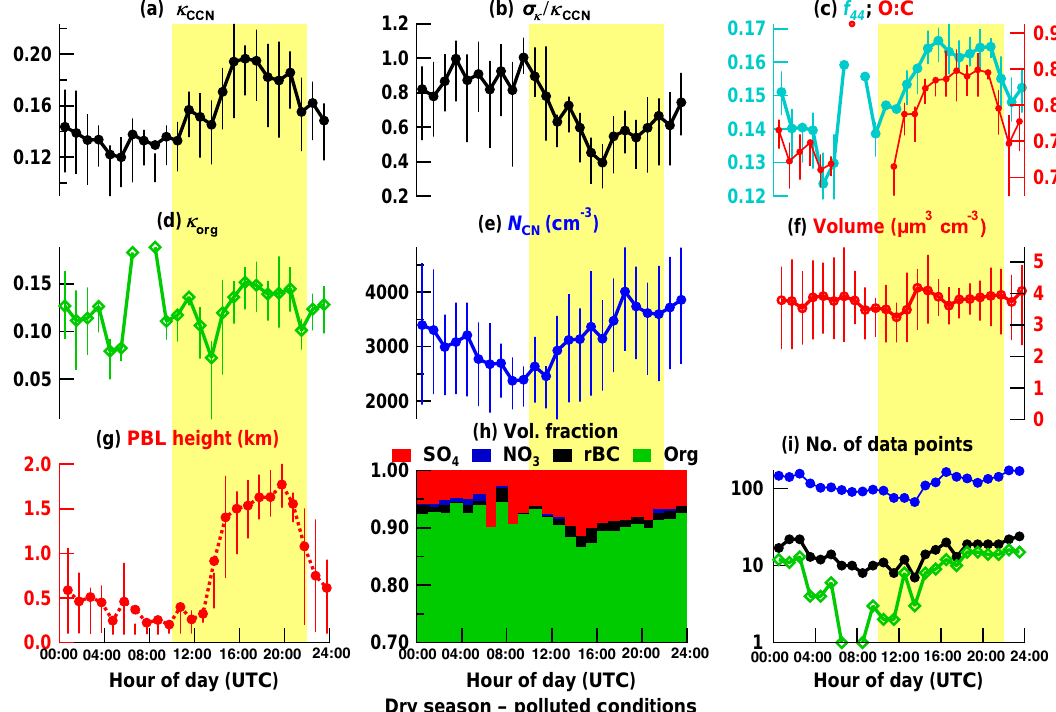
Figure 6. Diel variations of aerosol properties and meteorological parameters for urban pollution air masses during the dry season (analogous to Fig.